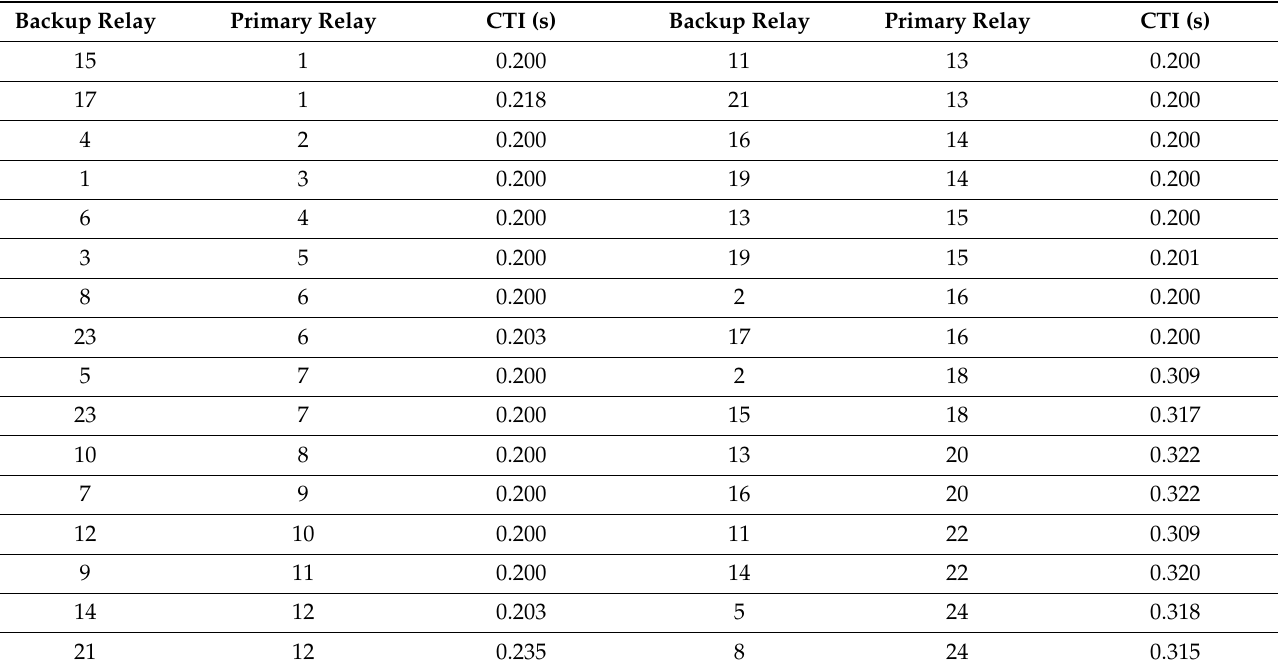
Table 9. CTI for the Meshed 9-bus Test